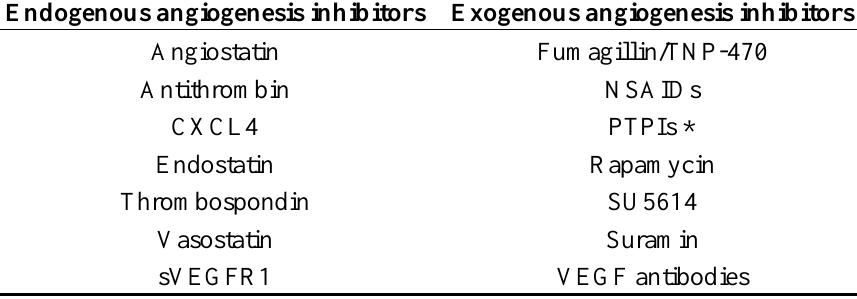
Table 1. Selected angiogenesis inhibitors discussed in this